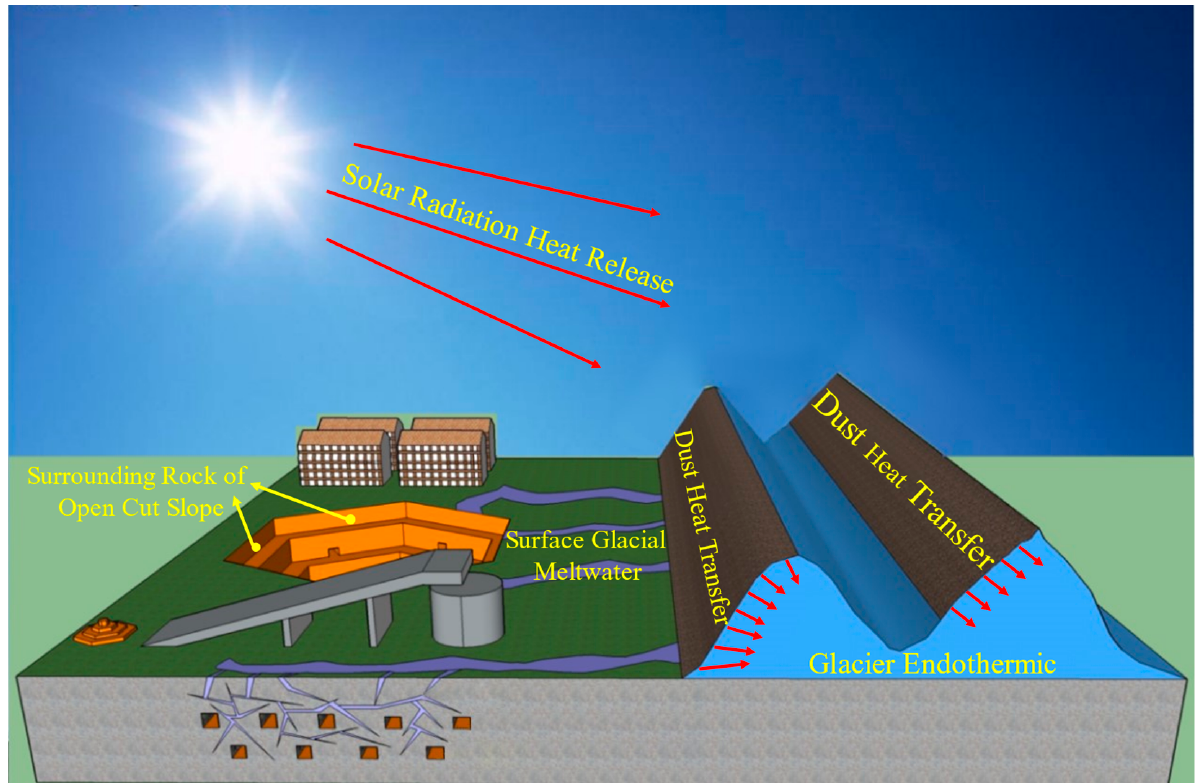
Figure 15. ( a ) XRD pattern of mineral dust. ( b ) Glacial dust mineral content.